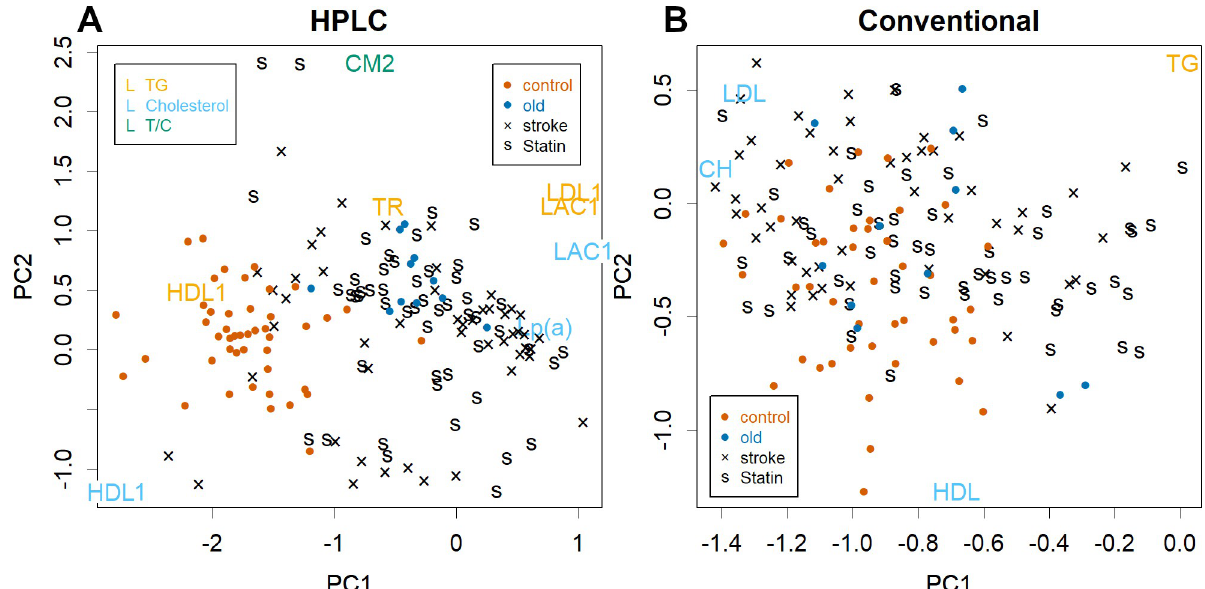
Fig 1. Biplot display of PCA. A . amount of each class and B . conventional enzymatic method (commonly used). Red dots: control samples; blue dots: elder controls, black: stroke patients, s; statin takers. In panel A, class names represent PC for representative items. Orange: TG, blue: cholesterol, green: TG/cholesterol ratio. In panel B, TG: total TG, CH: total cholesterol. In the panels, axes are for items; those for samples are omitted for simplicity (see S3 Fig in S1 File).